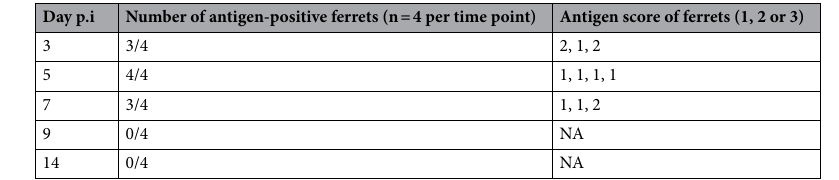
Table 3. Incidence of SARS-CoV-2 antigen-positive nasal turbinates and antigen scores. NA, no antigen- positive cells detected in any of the ferrets at the respective time points; Antigen scoring system: 1, less than 50 positive cells per section; 2, 50–100 positive cells per section; 3, > 100 positive cells per section.